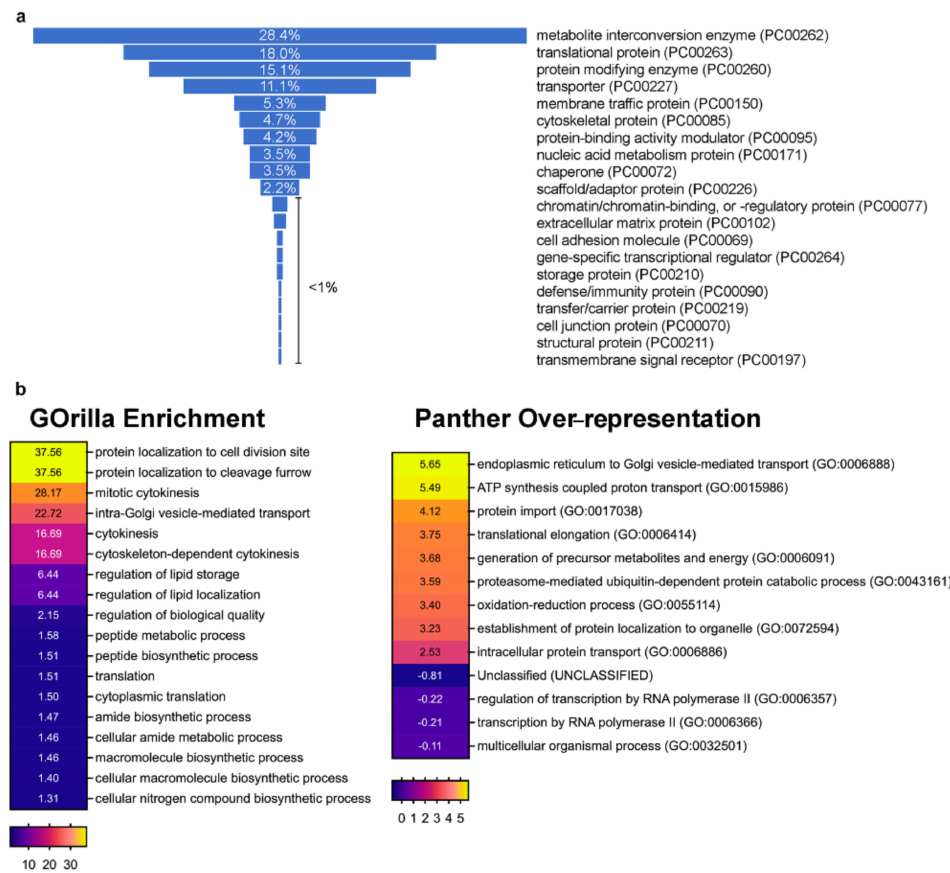
Figure 2. Protein Classes and GO analyses. ( a ) Funnel graph showing the classes of proteins identified in our AP-MS experiments and classified according to PANTHER database [41]. The percentage for each class is indicated. See also Supplementary Table S2 for details. ( b ) Heat maps showing the GO annotation enrichment profiles of the dGOLPH3 interactome. GO enrichment profiles were analyzed using GOrilla tool [42] under the category “process” and PANTHER database [41] under the category “GO-slim biological process”. Over-represented/enriched GO terms are shown in different color shades according to their fold enrichment as indicated in the color scale bar at the bottom; actual fold enrichment values are shown within the heat map (see Supplementary Tables S3 and S4 for p -values). For simplicity and to improve visual representation, for the PANTHER over-representation analysis only the headings for each GO-slim biological process are shown in the graph, while the full results are reported in the Supplementary Table S4. Only results for Bonferroni-corrected analysis ( p < 0.05) were